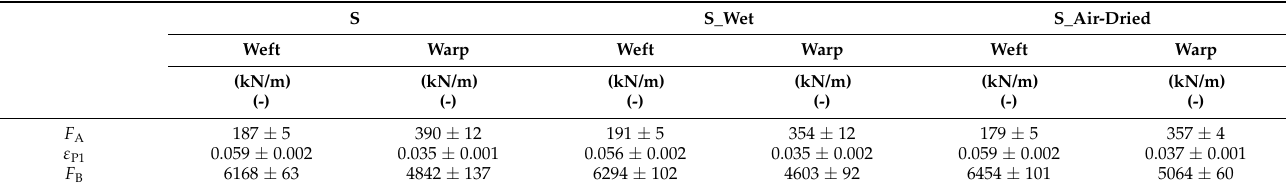
Table A7. Longitudinal stiffnesses of S type fabric.